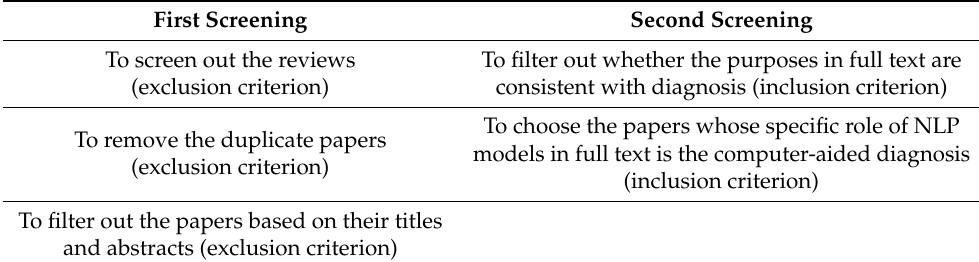
Figure 3. The flowchart of literature identification and screen process. Table 2. The inclusion criteria and exclusion criteria of the articles.